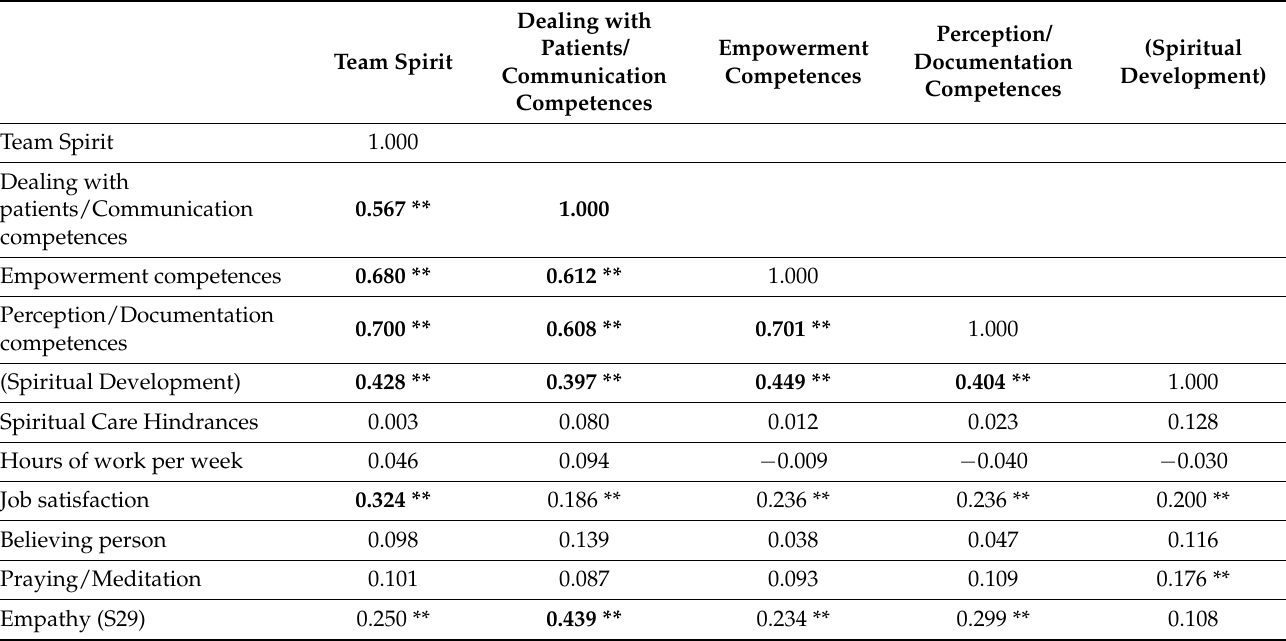
Table 4. Correlation